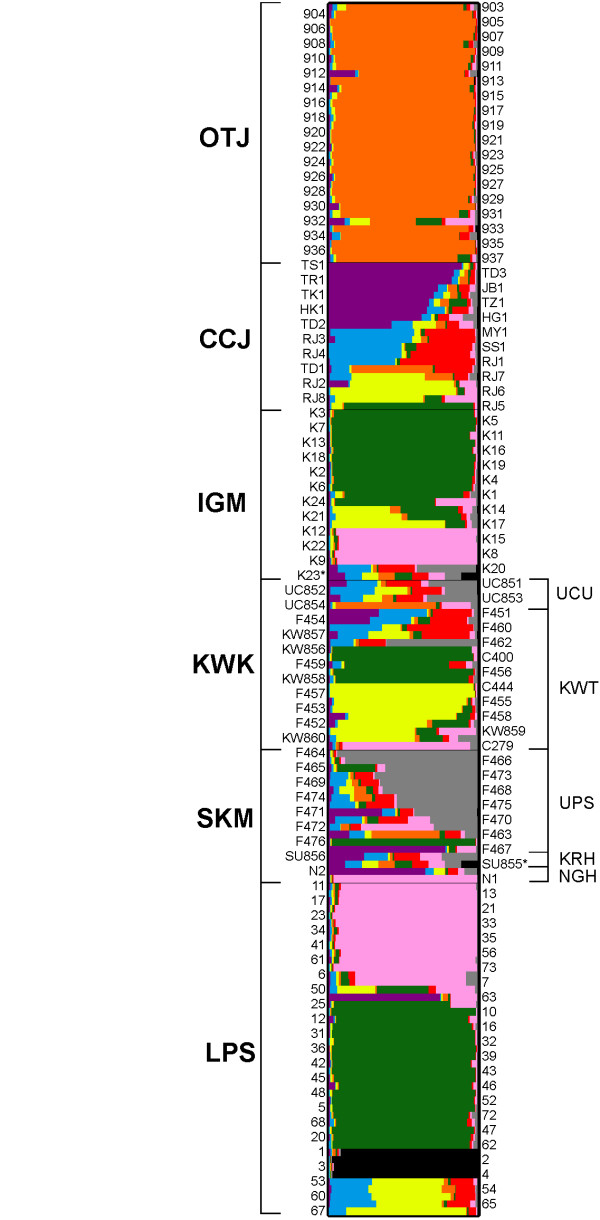
Bar plots of estimates of membership coefficient (Q) for each individual for the inferred clusters (K = 9) with maximum log-likelihood probability. Bar colours and lengths represent inferred clusters and Q, respectively.